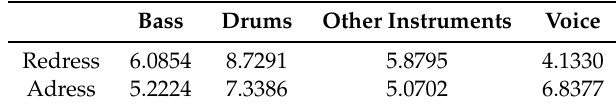
Table 3. Av. SNR (dB) of the source estimates: 4-source mixtures.